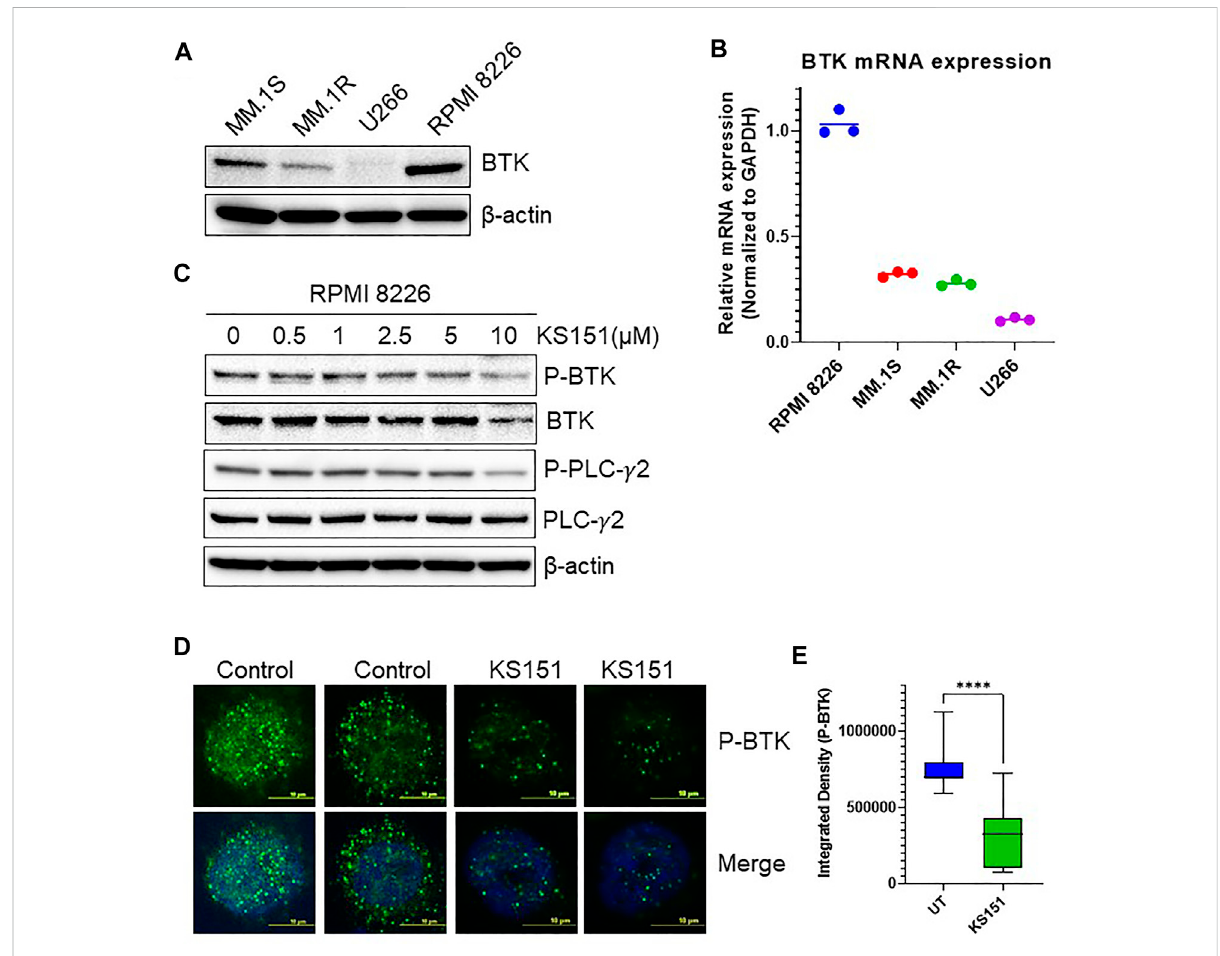
FIGURE 4 KS151 inhibits BTK signaling pathways. (A) , Expression of BTK in different MM cell lines determined by western blot. (B) , Expression of BTK in various MM cell lines determined by real-time quantitative PCR (QPCR). GAPDH was used as an internal control. (C) , KS151 suppresses phosphorylation of BTK and PLC γ 2 in a dose-dependent manner. MM.1R cells were treated with mentioned amount of KS151 for 24 h and immunoblottingwasperformed.Asaloadingcontrol,thestrippedmembranewasprobedwitheitherBTK,orPLC γ 2or β -actinantibodies. (D)